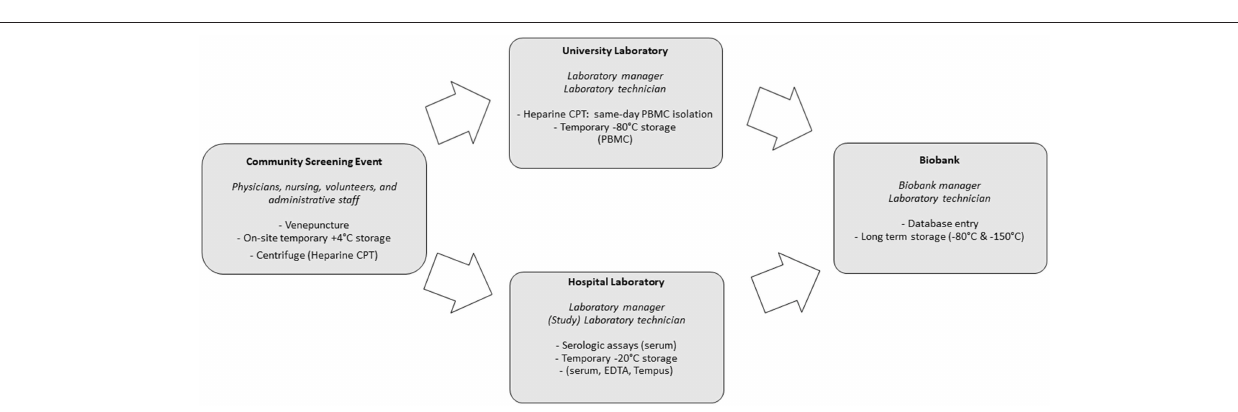
FIGURE 2 | Sample flow and roles in community screening and